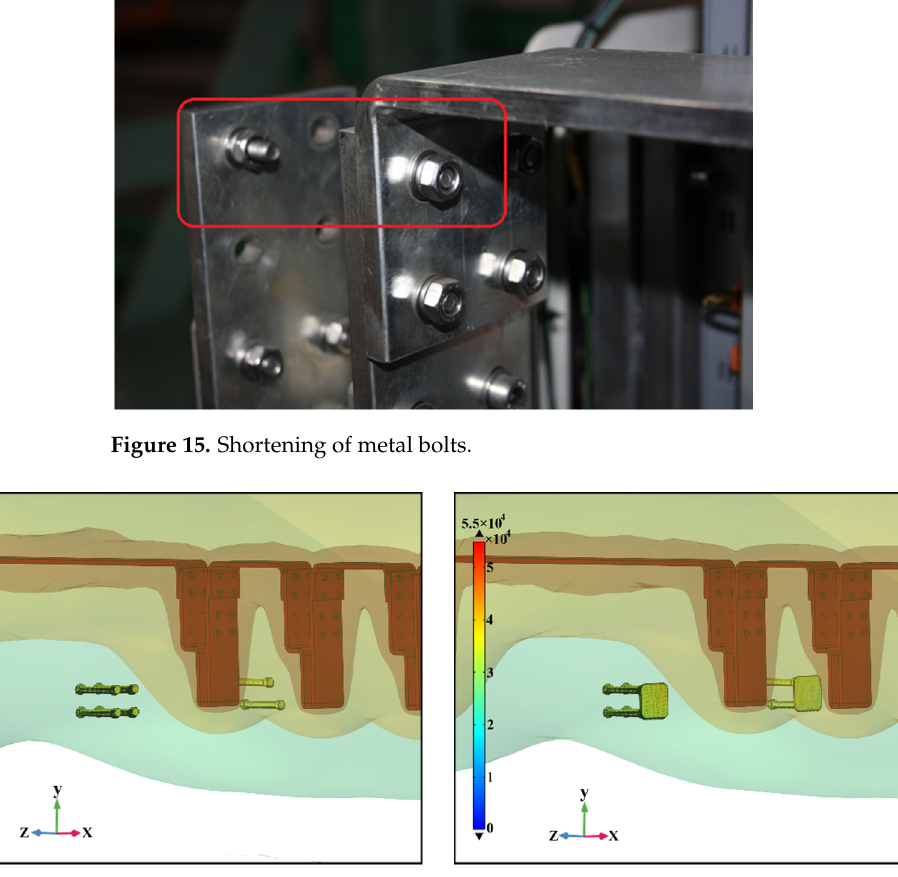
Figure 16. Effect of metallic plates on bolts: ( a ) initial state; ( b ) after the bolts were covered with metal plates.